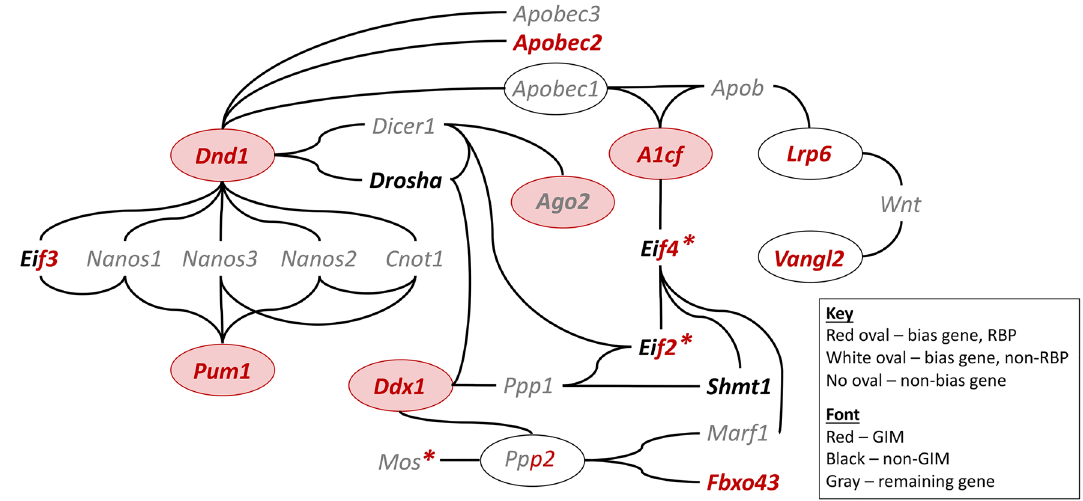
Figure 5. Network of interactions and functional dependencies. Genes were included if they show no more than two steps (nodes) from a bias gene. The Eif and Ppp gene families are shown in both red and black font because some family members are GIMs, others non-GIMs, and still others are ‘remaining genes’ or were not detected 12 . Red asterisks denote non-Mendelian segregation. See Table S5 and Fig. S3 for additional